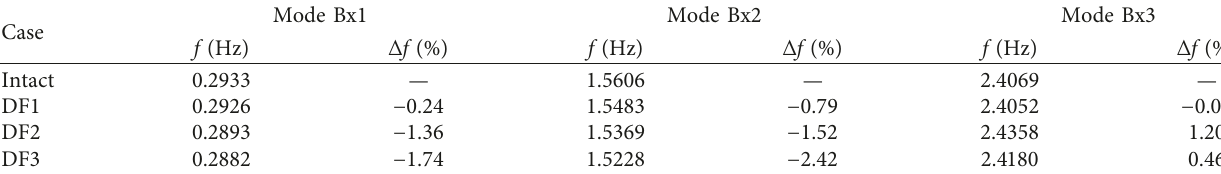
Table 13: Natural frequencies of along-wave bending modes: damage type 3.